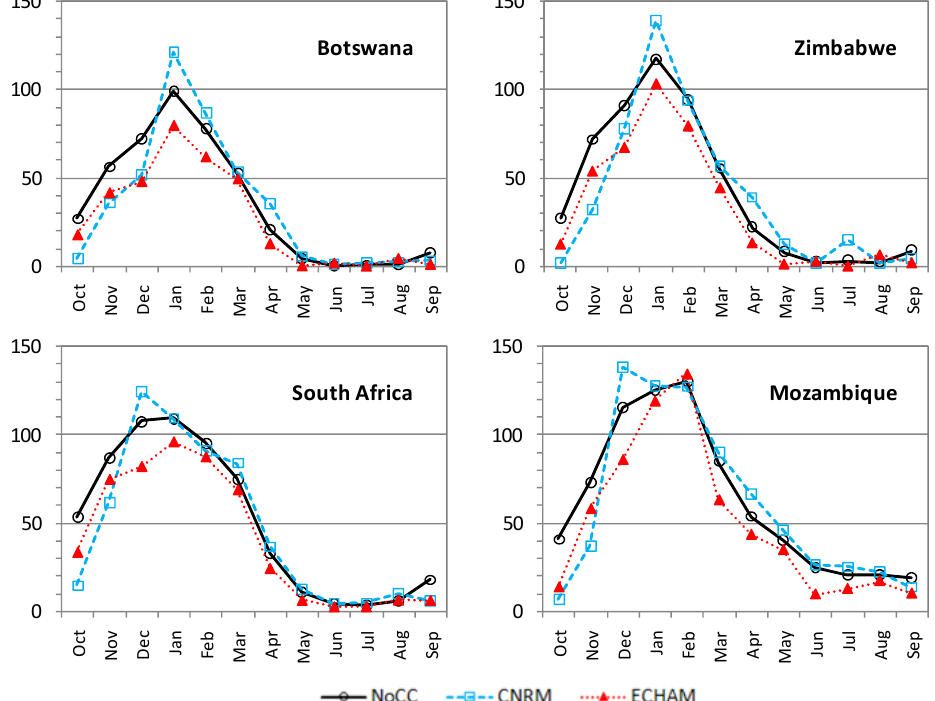
Figure 7. Mean monthly precipitation (mm) under the 1971–2000 climate baseline and climate change scenarios for